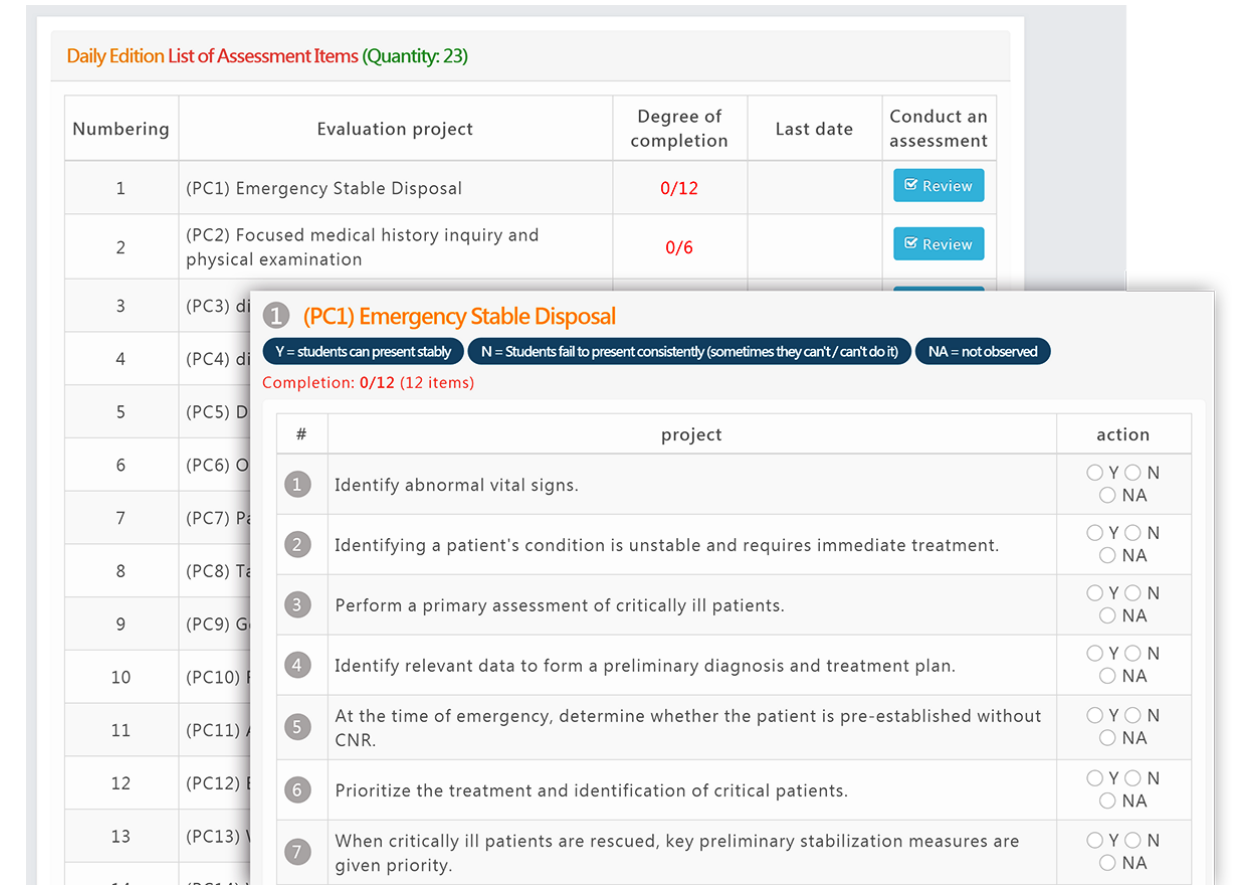
Figure 4. Daily milestone